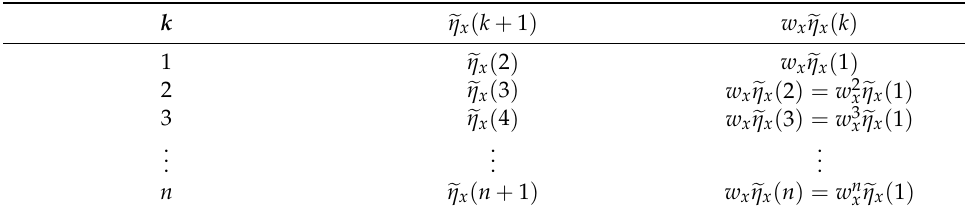
Table 1. Evolution of the control error (cid:101) η x in kT 0 instants of time.